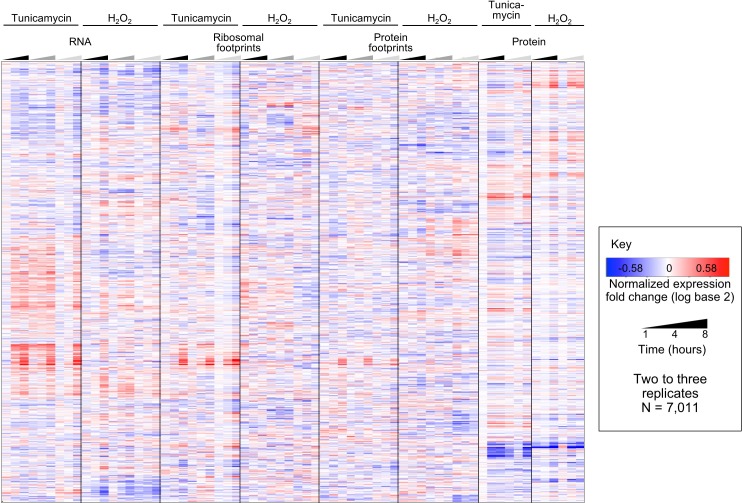
Replicates are consistent even prior to principal component analysis.The heatmap shows integrated data for the log base two transformed Z-scores calculated for each time series experiment, prior to removing one of the three replicates and processing by Principal Component Analysis. The total number of genes is 7,011, corresponding to the data shown in Figure 3, main text. For visualization purposes, the replicates are indicated in different shades of black/grey in the time triangles. Replicates are highly consistent with each other.